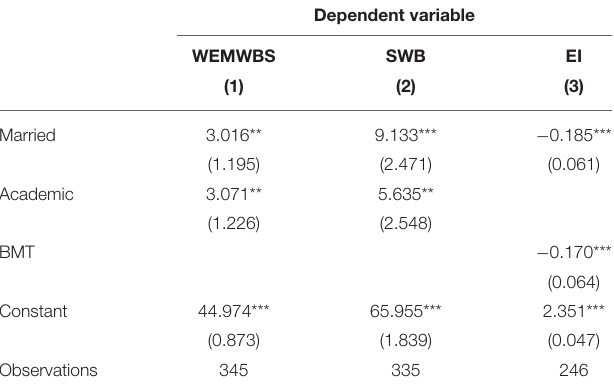
TABLE 5 | Linear regression results in